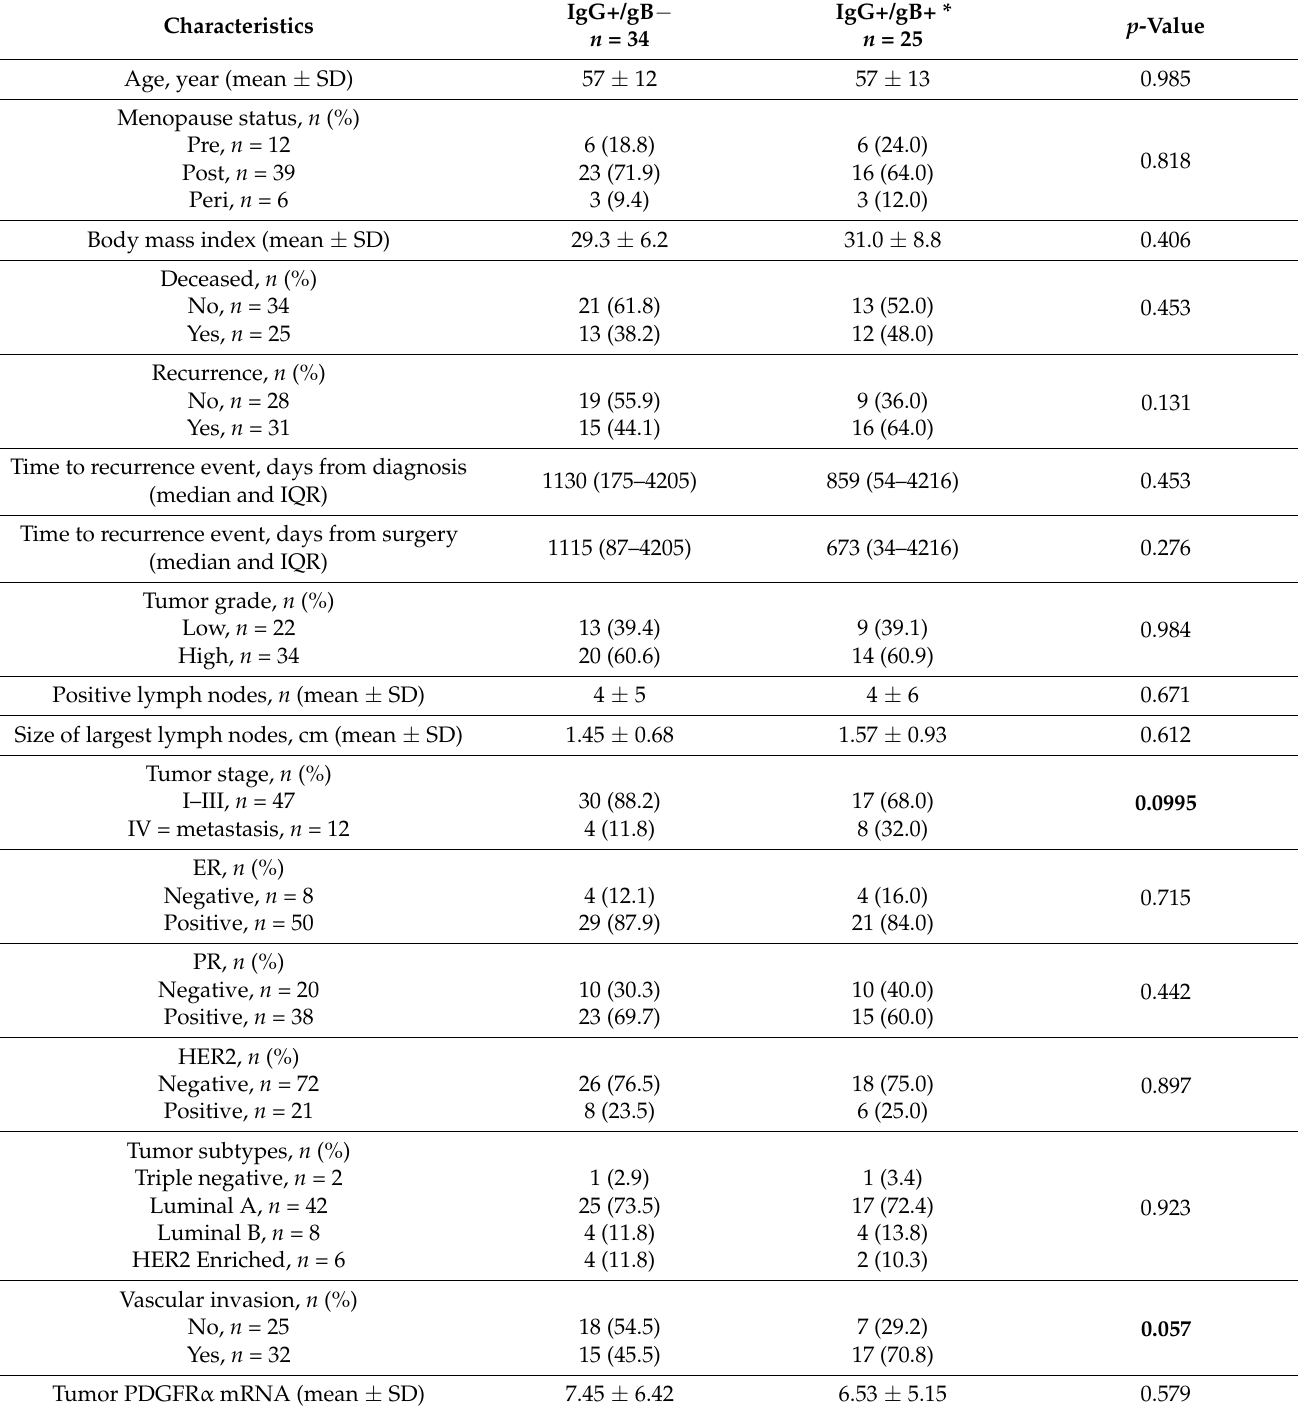
Table 5. HCMV IgG seronegative and seropositive patients with and without detection of HCMV gB in breast tumors: univariate analysis for patient